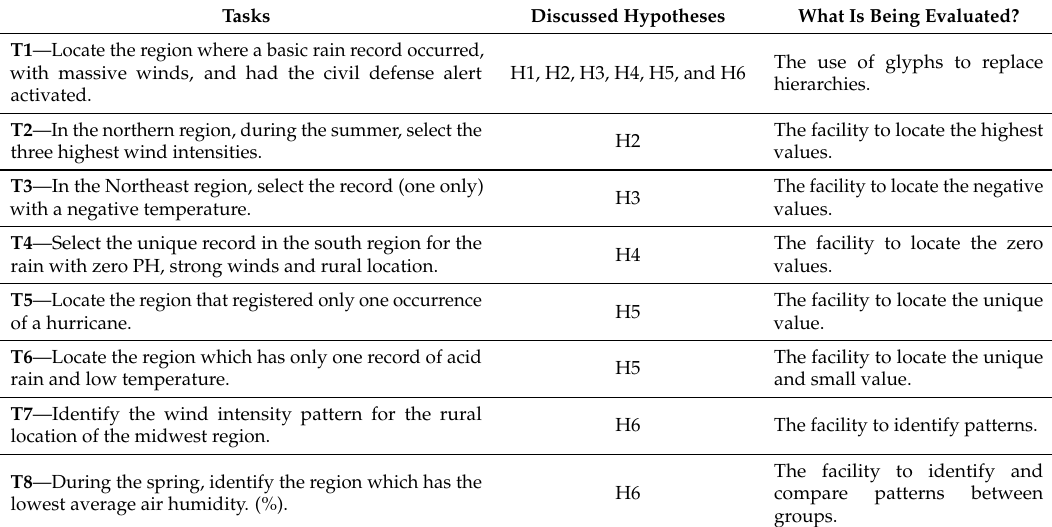
Table 3. List of tasks used in the